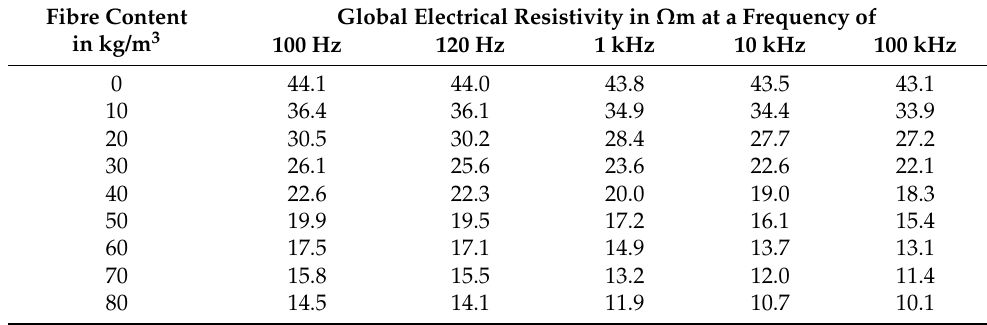
Table A20. Results of the resistivity measurements of the concrete mixture 32-60-300-00-F3. Fibre